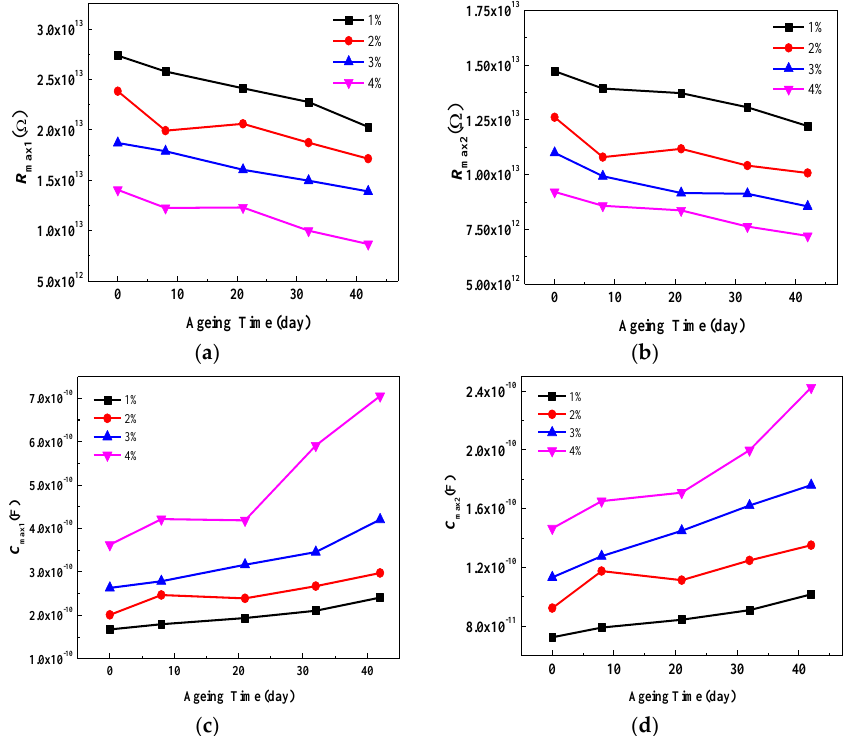
Figure 5. Resistances and capacitances of maximum and second maximum R - C branches with different times. ( a ) R max1 ; ( b ) R max2 ; ( c ) C max1 ; ( d ) C max2 .